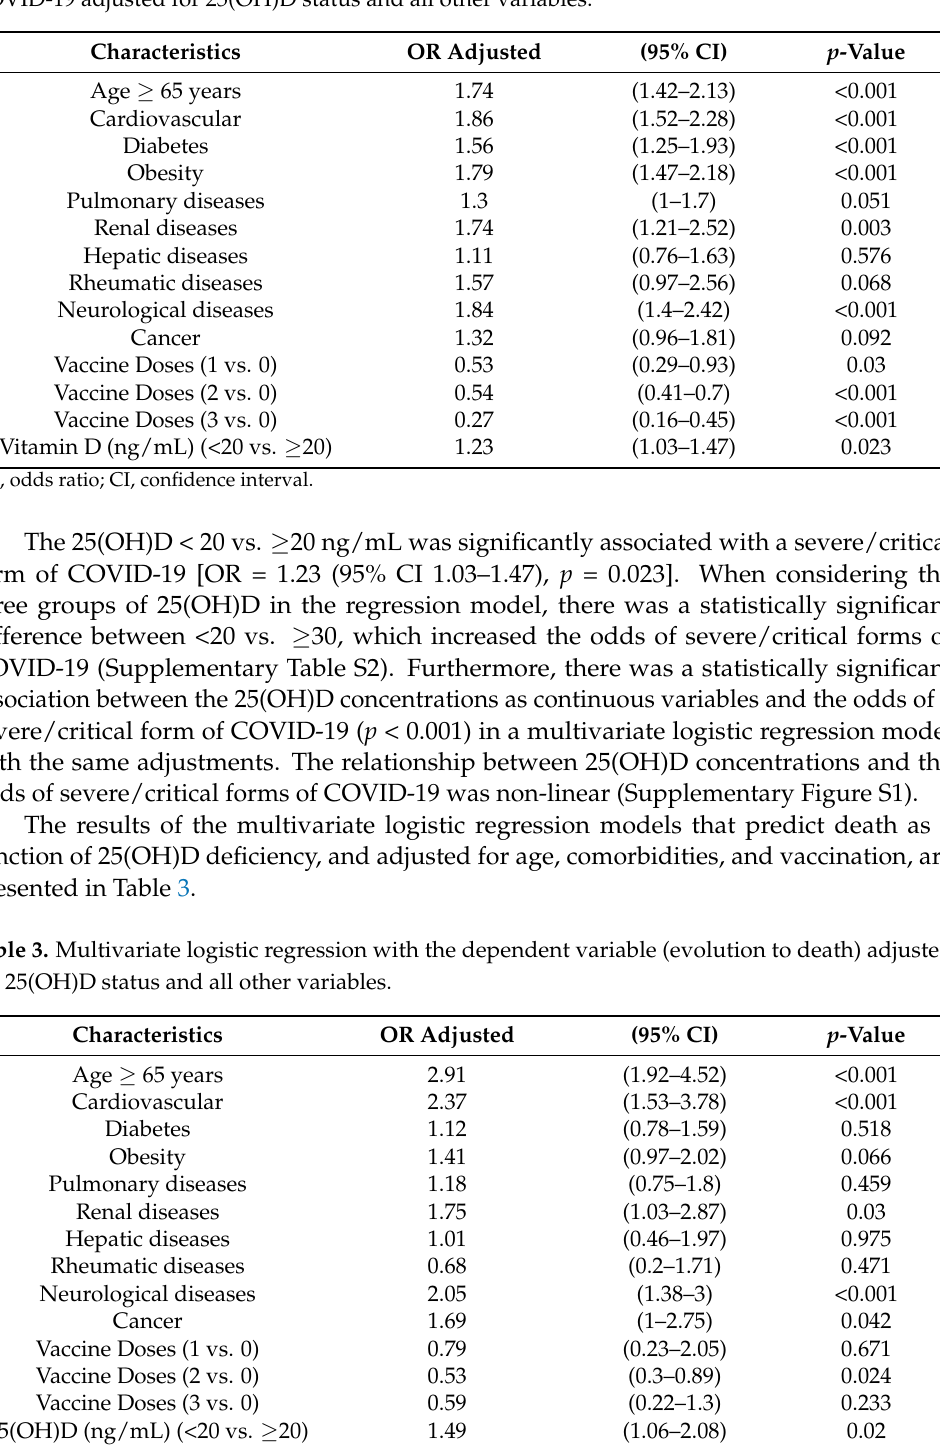
Table 2. Multivariate logistic regression with dependent variables and severe/critical forms of COVID-19 adjusted for 25(OH)D status and all other variables.